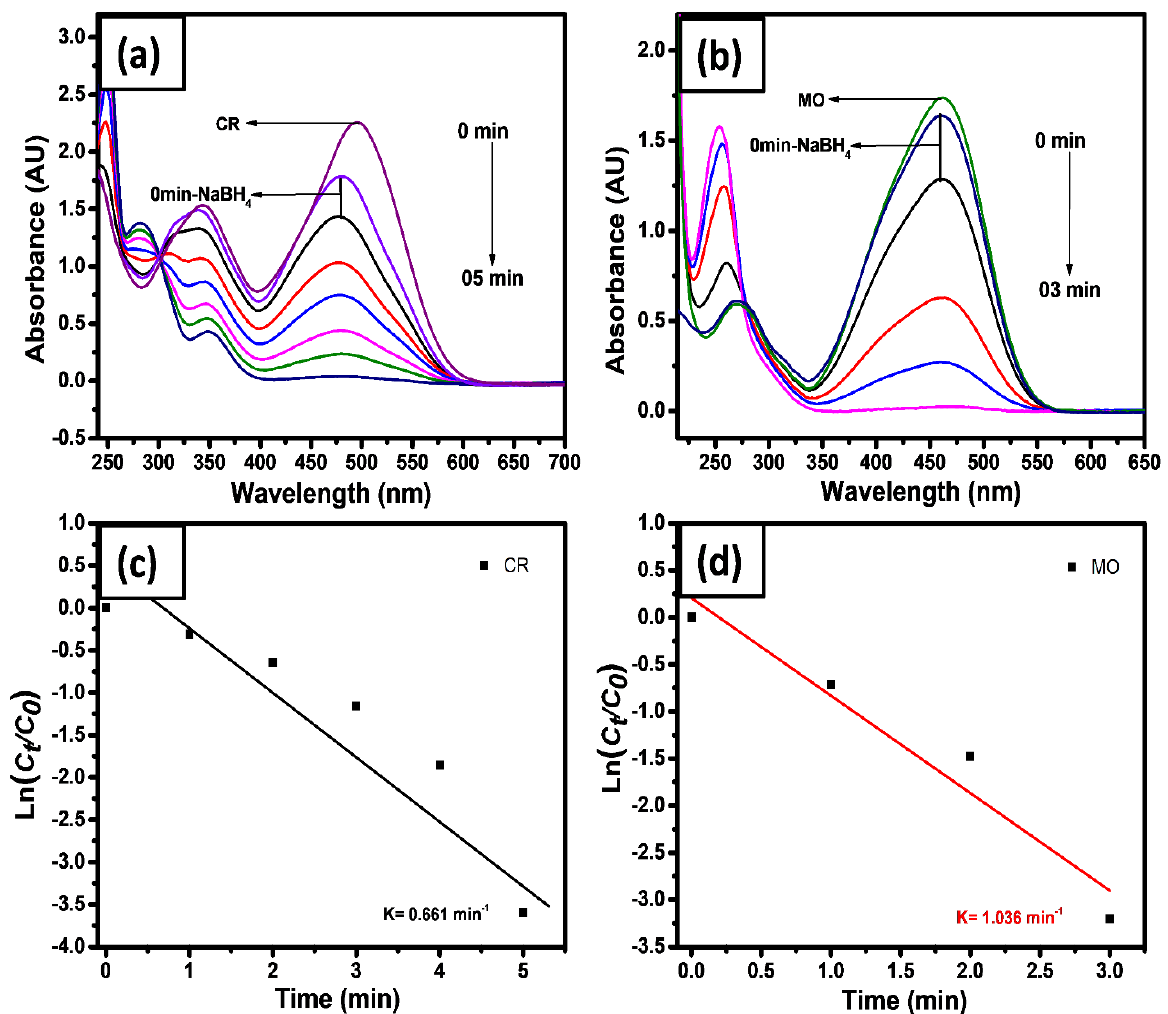
Figure 6. Typical UV-visible absorbance spectra of CR ( a ), MO ( b ), and their and ln( A t / A 0 ) vs. time plot for the reduction reactions ( c , d ), where 0.2 gm of the amount of the GL/Co − SnO 2 catalyst was used respectively.